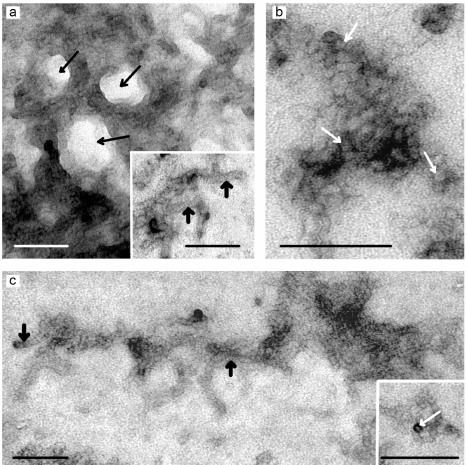
Figure 3. TEM images of hydrogels formed from dendrimer solutions in water: TG2 @10% Glc ( a , b ), PG2 @10% Glc ( c ). Spherical particles (white arrows) and fibres (thick black arrows) are shown. The three-dimensional dendrimer network with pores (thin black arrows) formed by spherical particles and fibres as well as aggregates of spherical particles ( b ) are observed. Negative staining with phosphotungstic acid. Scale bars represent 100